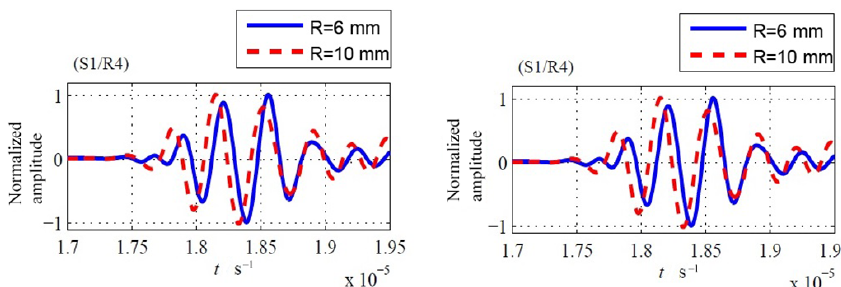
Figure 9. Measured echo signals for the propagation paths (S1/R1) and (S1/R4) of a plane annular array with five elements for sphere radii of 6 and 10mm (S: sending element, R: receiving element). The sphere is located at z = 13mm, which is the near-field length of the single elements of the annular array.